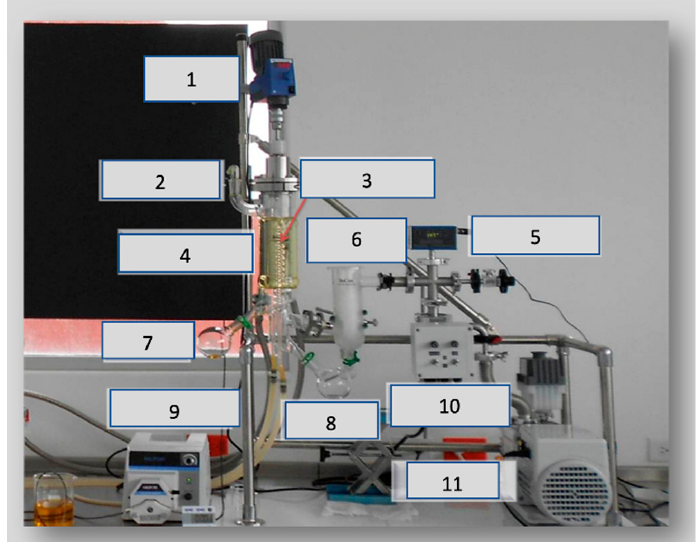
Figure 3. Lab-scale InCon ICL-04A short-path distillation. 1. Mixer; 2. feeding; 3. condenser; 4. evaporator; 5. vacuum gauge; 6. vacuum trap; 7. residue; 8. distilled; 9. peristaltic pump; 10. pump; 11. vacuum pump.